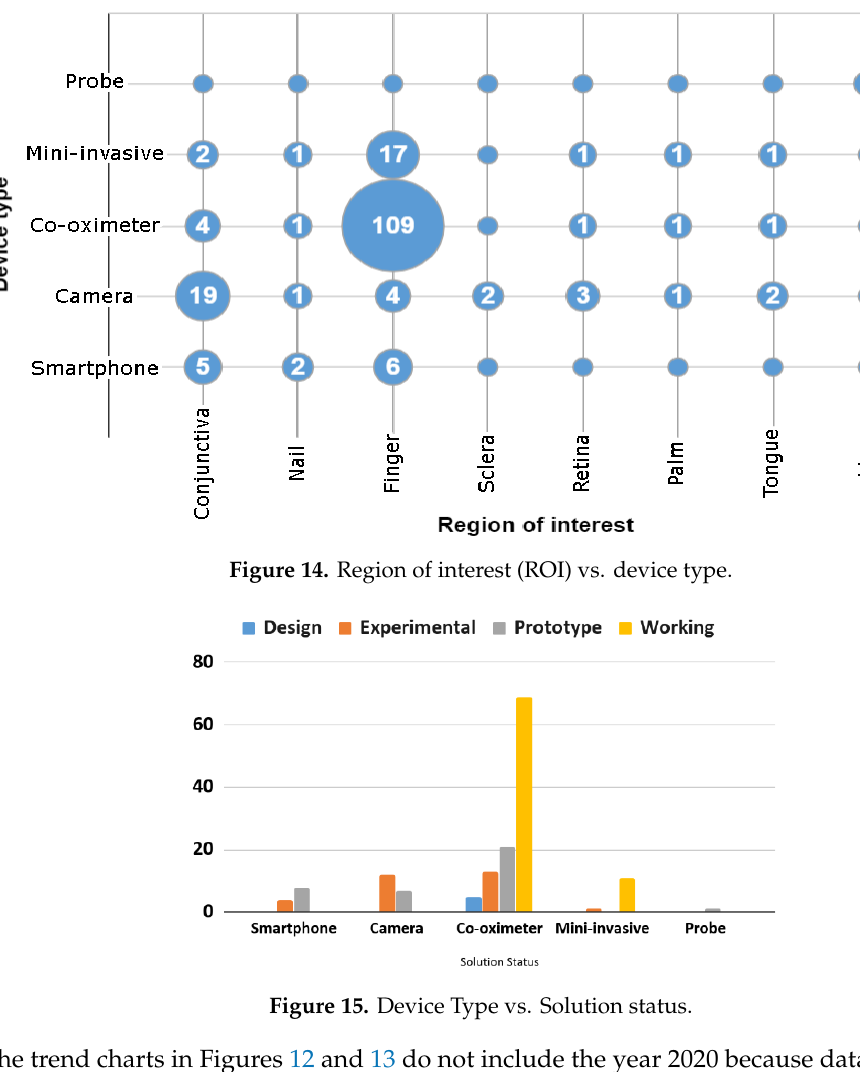
Figure 14. Region of interest (ROI) vs. device type.